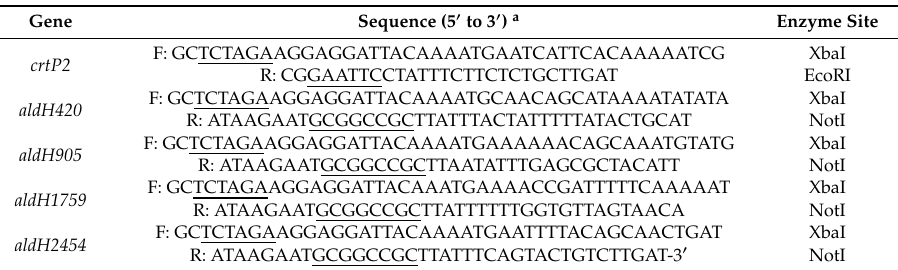
Table 2. Primers used in this